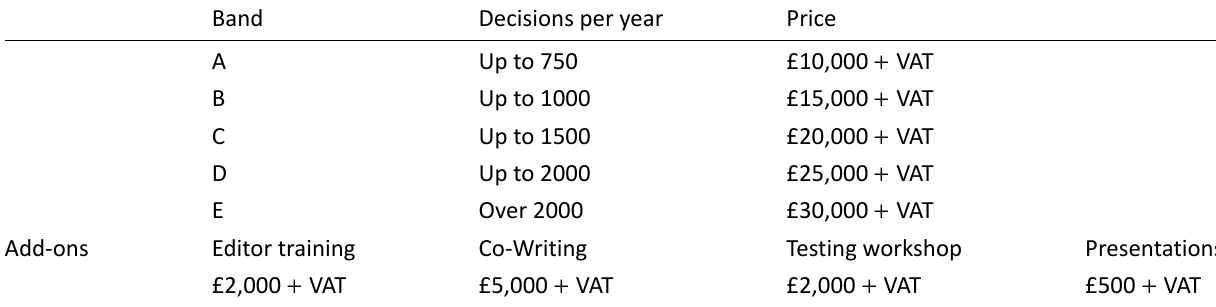
Table 2. Price plans for PlanX annual